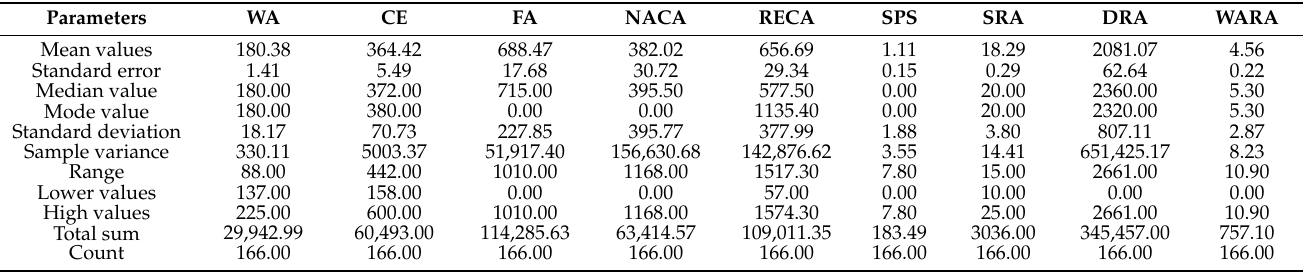
Table 1. Expressive inspection of the input